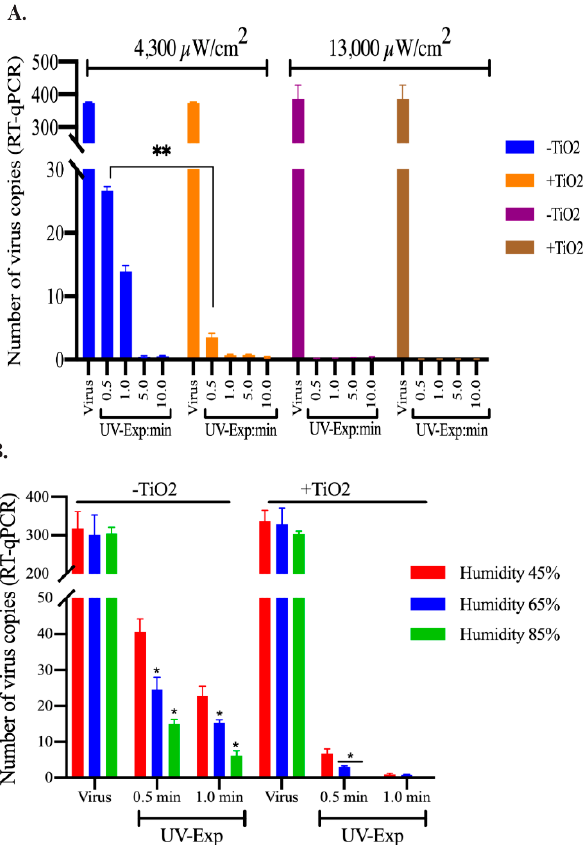
Figure 5. UV energy and humidity affected TNP mediated virus inactivation. ( A ) HCoV-NL63 virus aliquot (100 μ L) was placed on glass coverslips treated with or without TiO 2 and exposed to UV light for 0.5, 1, 5, and 10-min from a distance of 50 cm or 10 cm to achieve 4300 μ M/cm 2 and 13,000 μ M/cm 2 energy levels. Post-UV treatment, HCoV-NL63 was collected for viral RNA extrac- tion. Intact viral copies were calculated based on the standard curve generated above. ( B ). HCoV- NL63 virus aliquot (100 μ L) placed on TNP-coated or control (uncoated) coverslips were exposed to UV-lights for 0.5 and 1.0 min under 45%, 65%, and 85% relative humidities. Viruses from UV- untreated surfaces were used as controls. Post-UV treatment, viral genomic RNA was extracted and subjected for quantitation of genomic RNA in qPCR. Statistical analyses were performed using Prism 8.0 software and the p -values were calculated using 2-way ANOVA and the p -values are * <0.1, and ** <0.01.